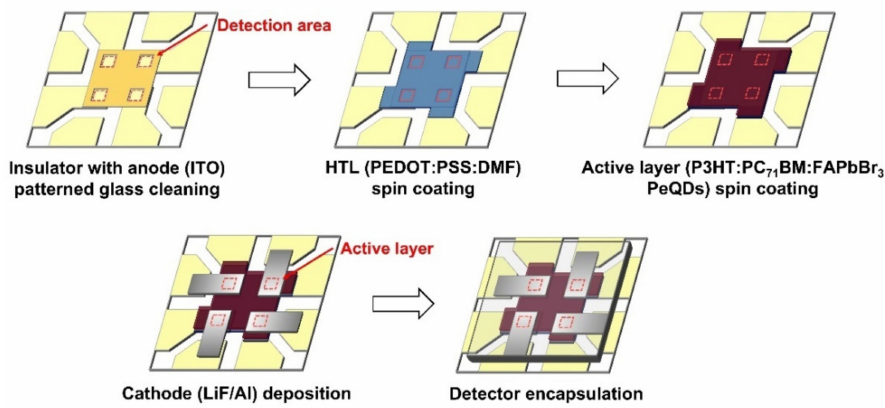
Figure 2. The fabrication flow of the detector with P3HT:PC 71 BM:FAPbBr 3